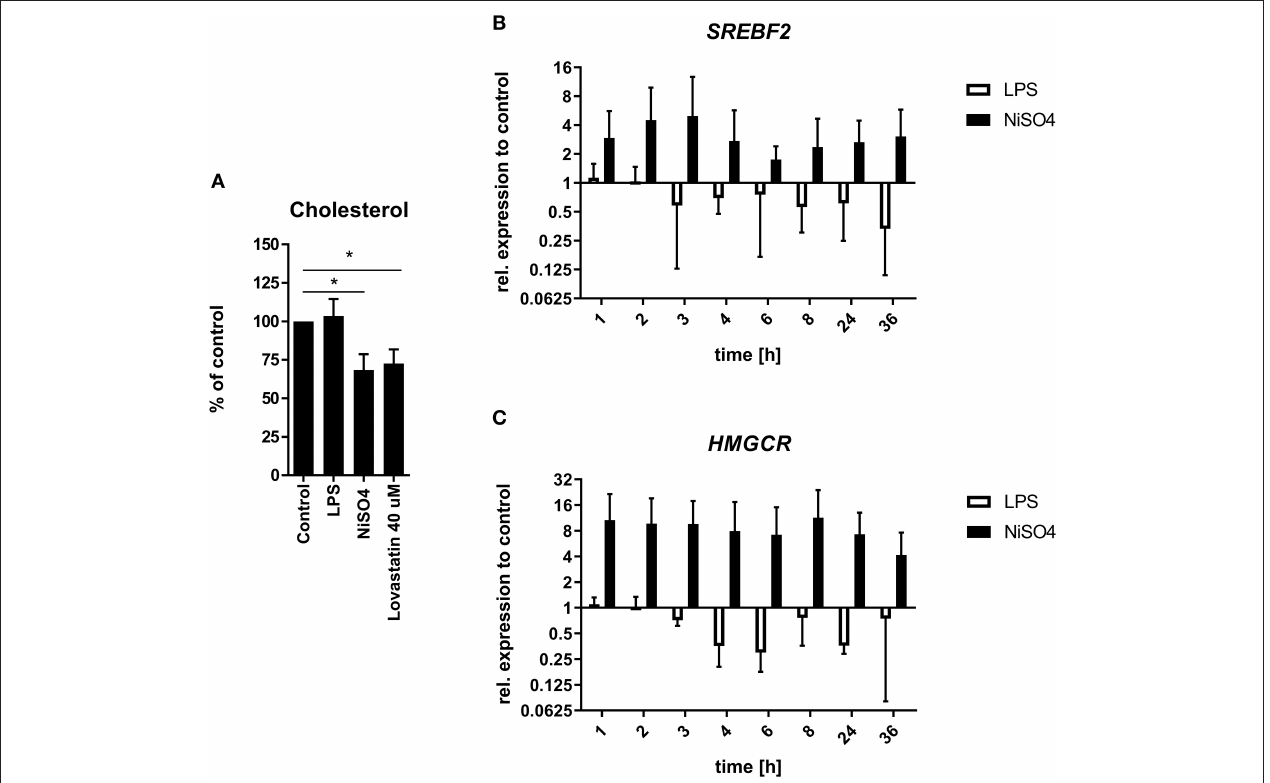
FIGURE 3 | Cellular cholesterol quantification and relative gene expression of relevant genes in LPS- and NiSO 4 -treated MoDCs. (A) Cellular cholesterol levels were determined fluorometrically using the Amplex Red Cholesterol Assay kit after lipid extraction from MoDCs treated for 24h. The fluorescence intensity was normalized to the protein concentration of the respective sample. Cholesterol/protein-ratios were then further normalized to the untreated control. Significance to medium control was calculated using Student’s t -test and is indicated with * p ≤ 0.05. The relative gene expression of sterol regulatory element-binding protein 2 (SREBF2, B ) as well as 3-hydroxy-3-methylglutaryl-coenzyme A reductase (HMGCR, C ) were analyzed at selected time points after treatment of MoDCs. Gene expression was measured by qRT-PCR and normalized to the gene expression of HPRT (housekeeping gene) and medium control. Plotted are mean and SD of the normalized data ( n = 3 donors). For each assay MoDCs were treated with medium only, 2.5 µ g/ml LPS, 400 µ M NiSO 4 or 40 µ M